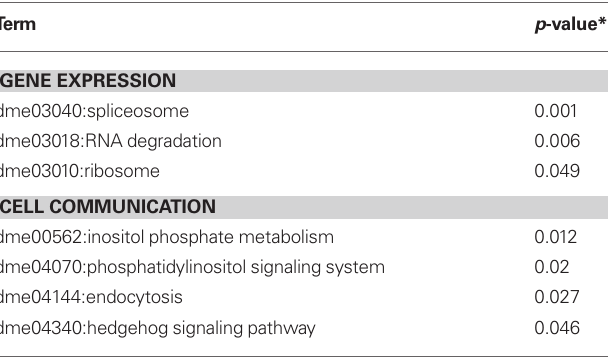
Table 3 | enriched processes in gene expression and cell communication related upregulated genes in AeD untreated flies.